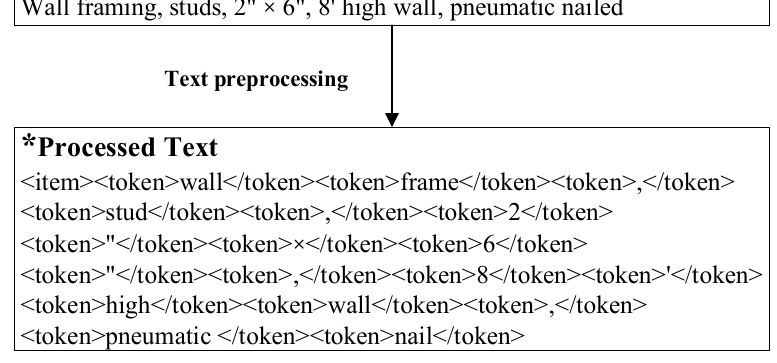
Figure 2. Work descriptions (adapted from RSMeans online [2]).